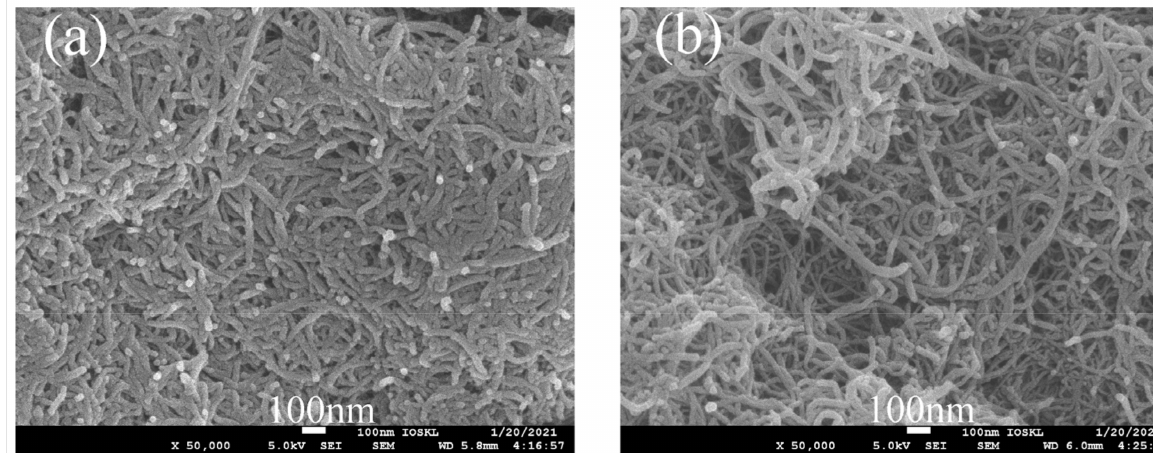
Figure 5. SEM images of ( a ) MWCNTs-COOH; ( b )